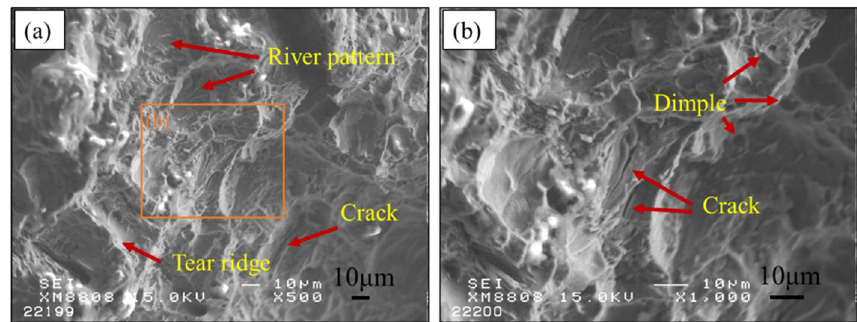
Figure 9. ( a ) SEM images of fracture surface of TiC reinforced TMC at 1473 K for 3.6 k s; ( b ) magnified